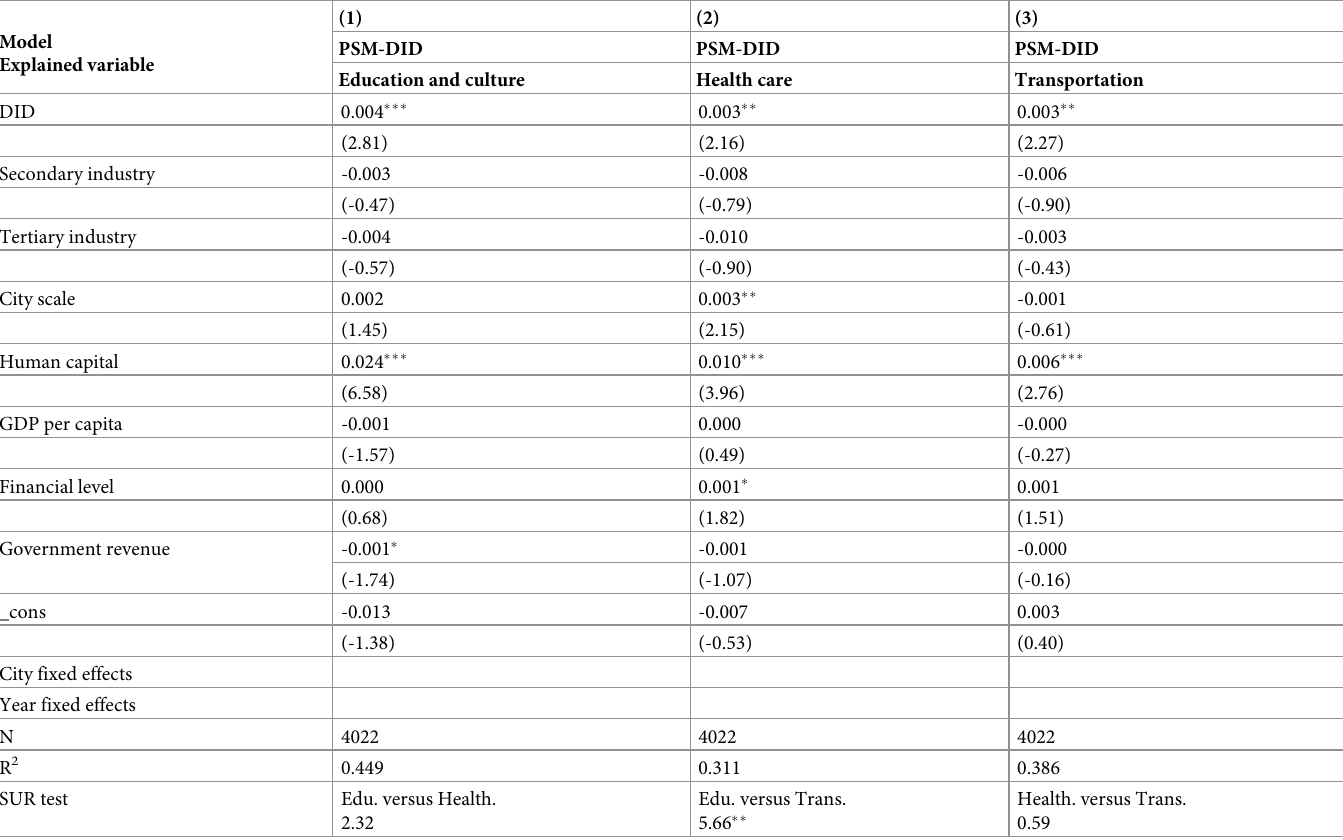
Table 6. A comparison of the policy impact on different aspects of public